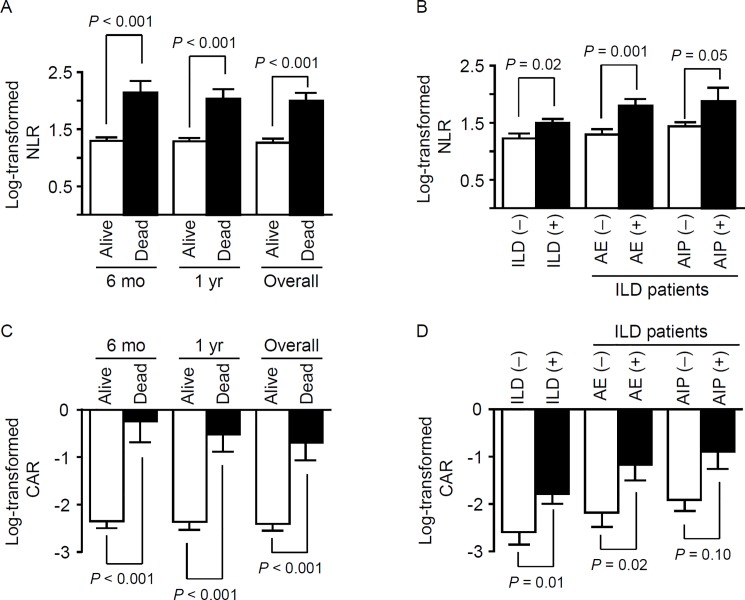
The neutrophil/lymphocyte ratio (NLR) and CRP/albumin ratio (CAR) according to clinically relevant subgroups.The NLR (A and B) and CAR (C and D) were significantly higher in the non-survivor group (versus the survivor group) and in patients with interstitial lung disease (ILD, versus those without ILD). Additionally, among patients with ILD, patients suffering an acute exacerbation (AE) of ILD had significantly higher NLR and CAR values. However, the presence of acute interstitial pneumonitis (AIP) was only associated with the NLR. Bars represent the standard error of the mean, and P values were calculated by the t-test.